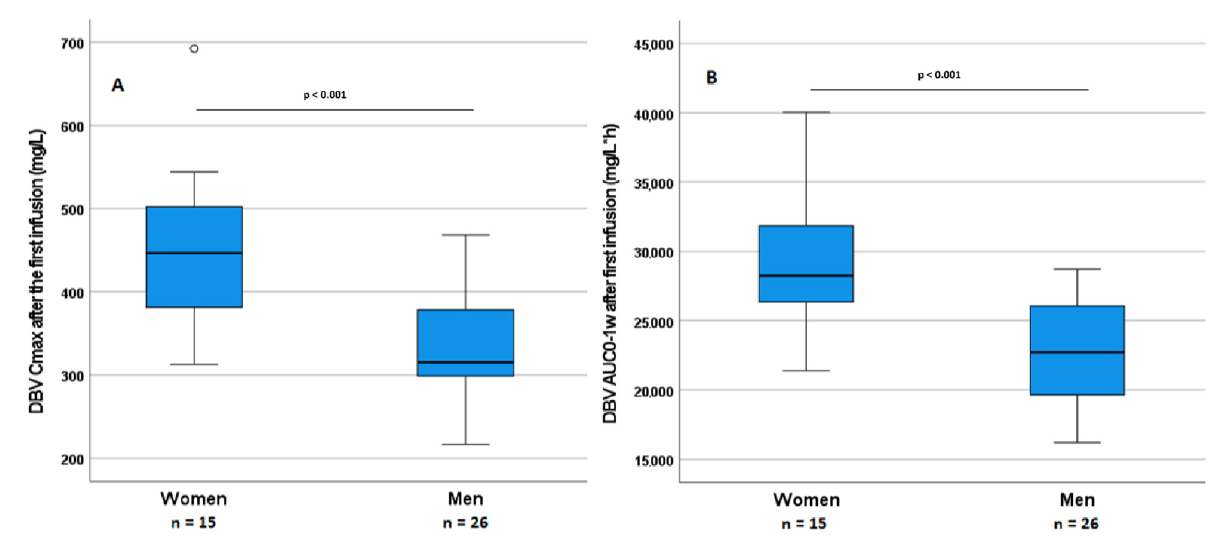
Figure 4. Differences in PK variables with regard to gender. From left to right, DBV C max and DBV AUC 0-1w differences in women and men ( p < 0.001).